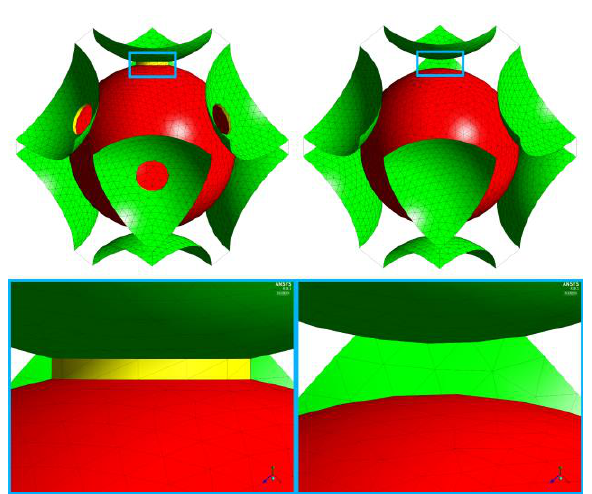
Fig. 4. Mesh obtained with the analysed methods: left – with additional cylinderical volumes ( R cyl% =20%); right – with reduction of granules radius ( R g% =95%).